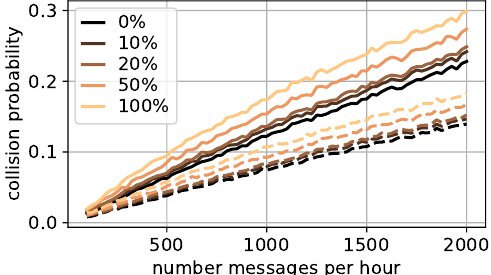
Figure A3. Coexistence study of listen before talk and random access. For 1000 messages per hour and only listen before talk traffic, 5.62% of all messages are delayed. The mean delay duration is 1.07 s for all delayed messages and 0.06 s among all transmitted messages. As expected, all values increase linearly with the number of messages and decrease linearly with increasing amount of random access traffic; however, listen before talk should always be preferred over random access if possible since at a cost of an average message delay of 0.06 s, the collision probability can be reduced by more than 5% for 1000 messages per hour. For 2000 messages, it is nearly 7% for a delay increase of 0.11 s on average per